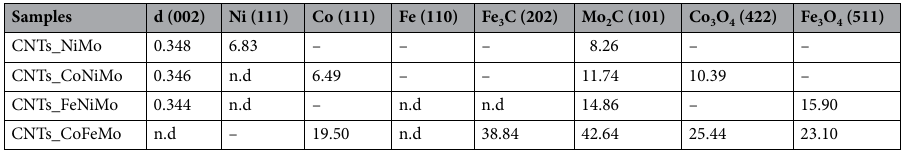
Table 6. Structural parameters analyzed by XRD for carbon products (interplanar spacing (d 002 )), and other components (crystal size).